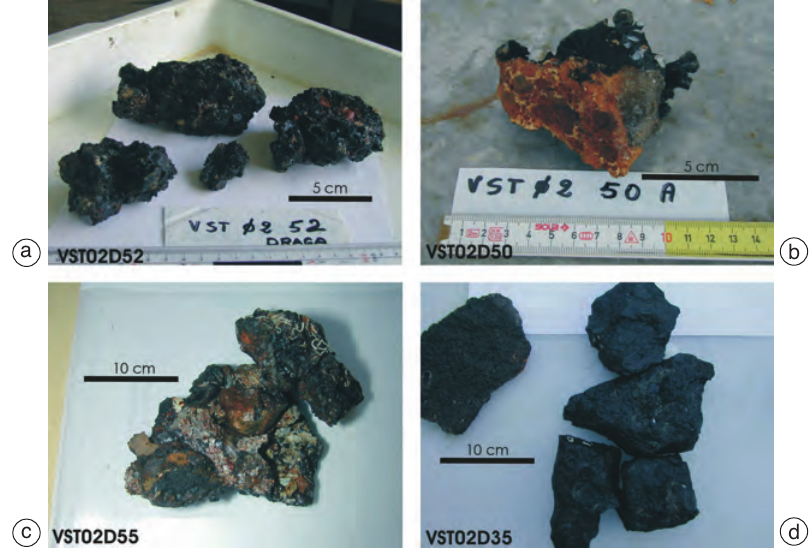
Fig. 9a-d. a) Explosive volcanic scoriae from the base of the southern axial summit of the Vavilov edifice: b) breccia sample from the upper western flank of the volcano; c) explosive volcanic scoriae from the northwest- ern Vavilov edifice; d) hydrothermal Mn